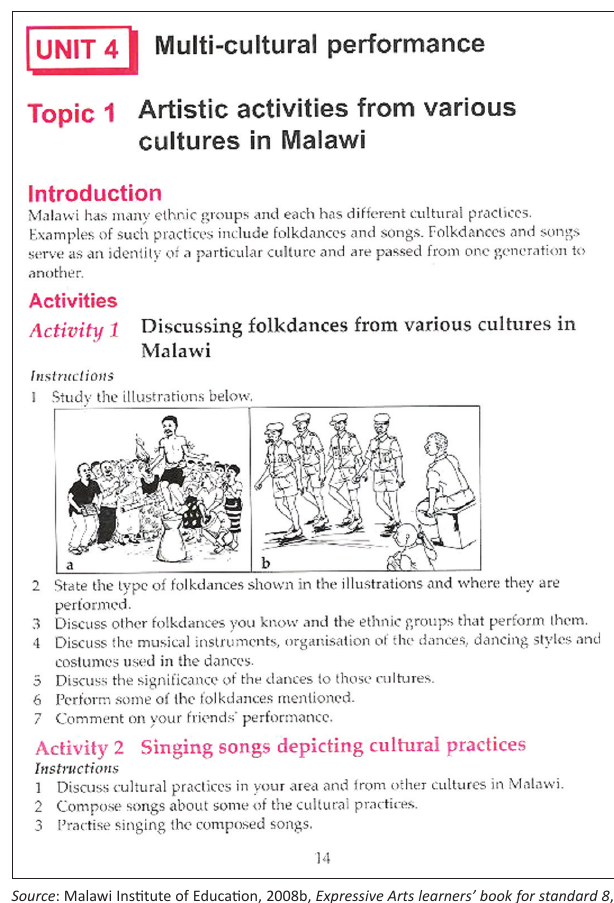
FIGURE 2: Teachers feel that the illustrations in the textbooks are inaccurate and they do not represent the ideas they were meant to represent